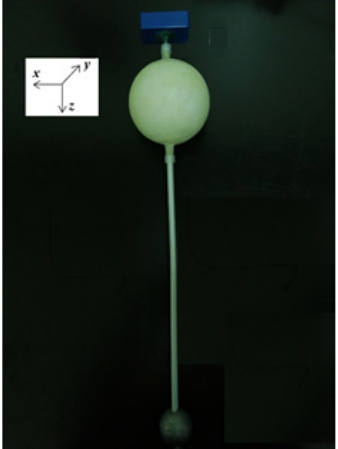
Figure 1. Spar buoy scaled model at “fixed-point” test configuration.